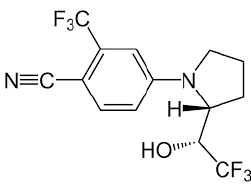
Figure 24. Chemical structure of ligandrol. Formula: C 14 H 12 F 6 N 2 O.